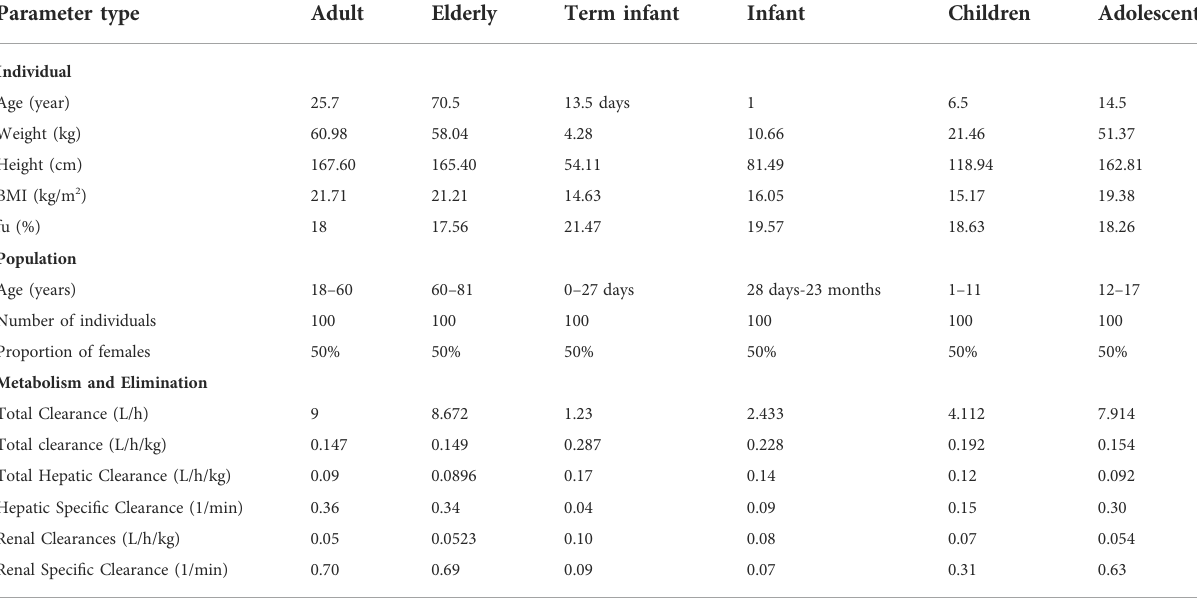
TABLE 2 Demographic information and drug-speci fi c parameters in virtual elderly and pediatric populations. Parameter